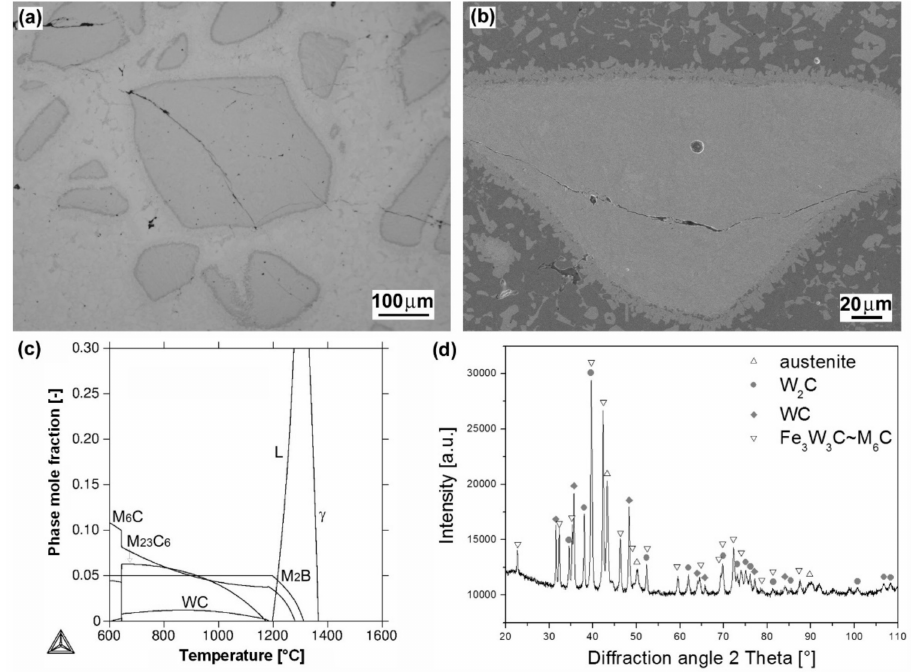
Figure 3. Characterization of “RD 571” hardfacing: overall microstructure visualized by LOM ( a ); detailed microstructure visualized by SEM ( b ); thermodynamic calculation of equilibrium phase composition depending on temperature ( c ); XRD-pattern representing experimentally determined phase composition ( d